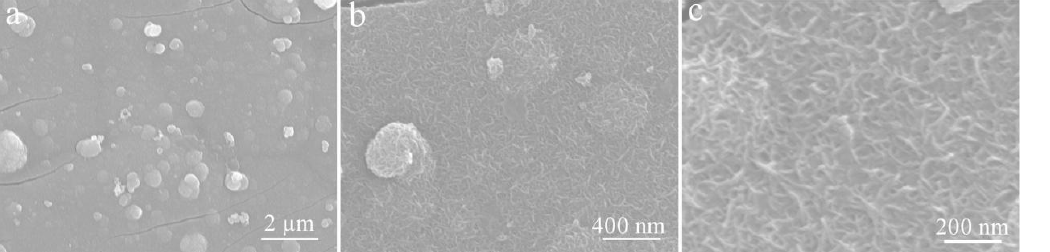
Figure 6. ( a ) Low-magnification and ( b , c ) high-magnificationFE-SEM images of single Ni 3 S 2 de- posited on the copper foam.